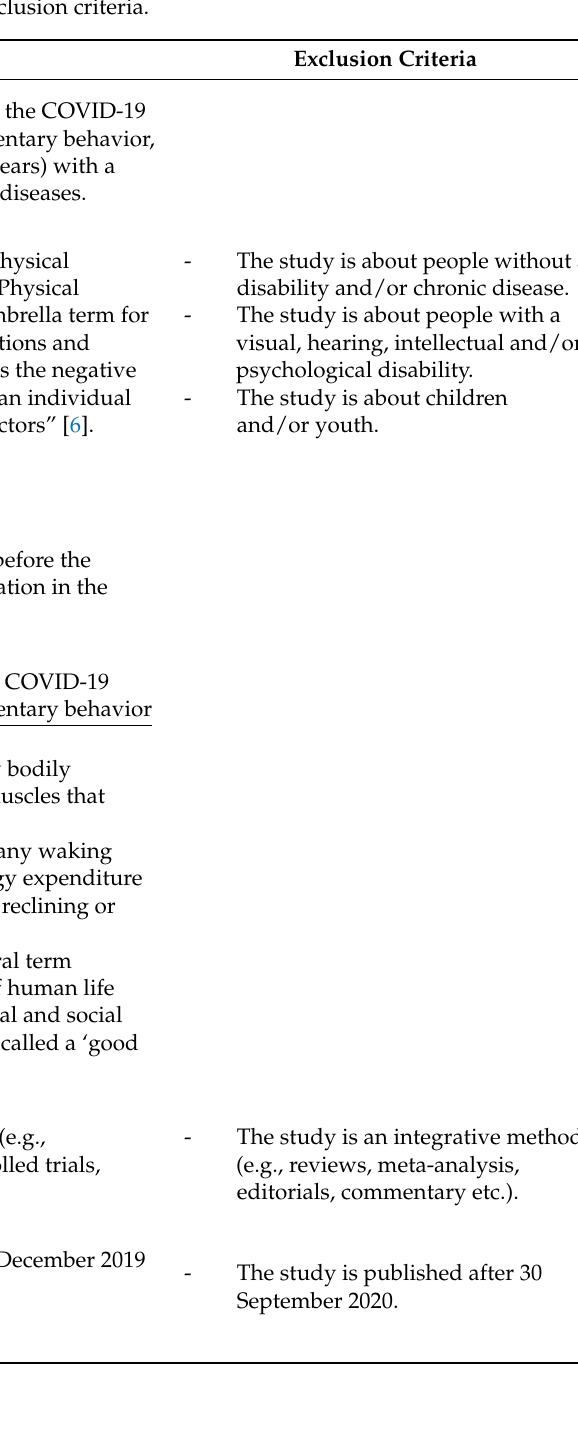
Table 1. Inclusion and exclusion